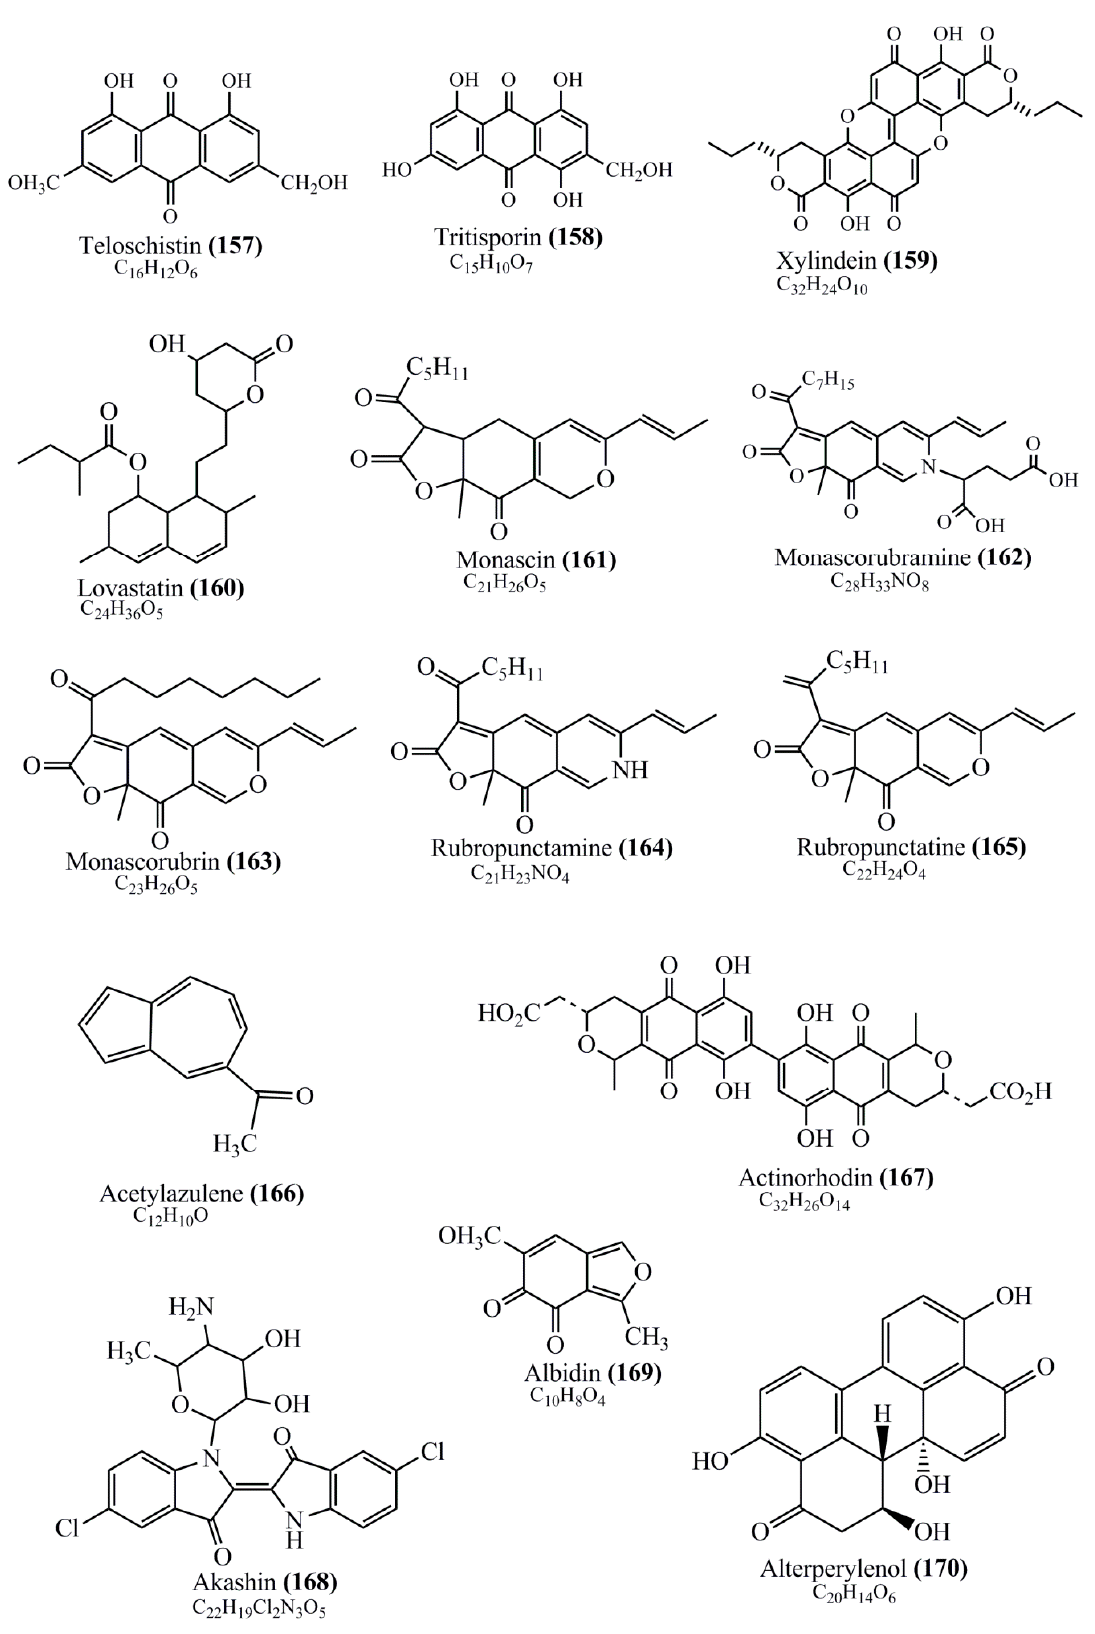
Figure 1. Figure 1. Continued.